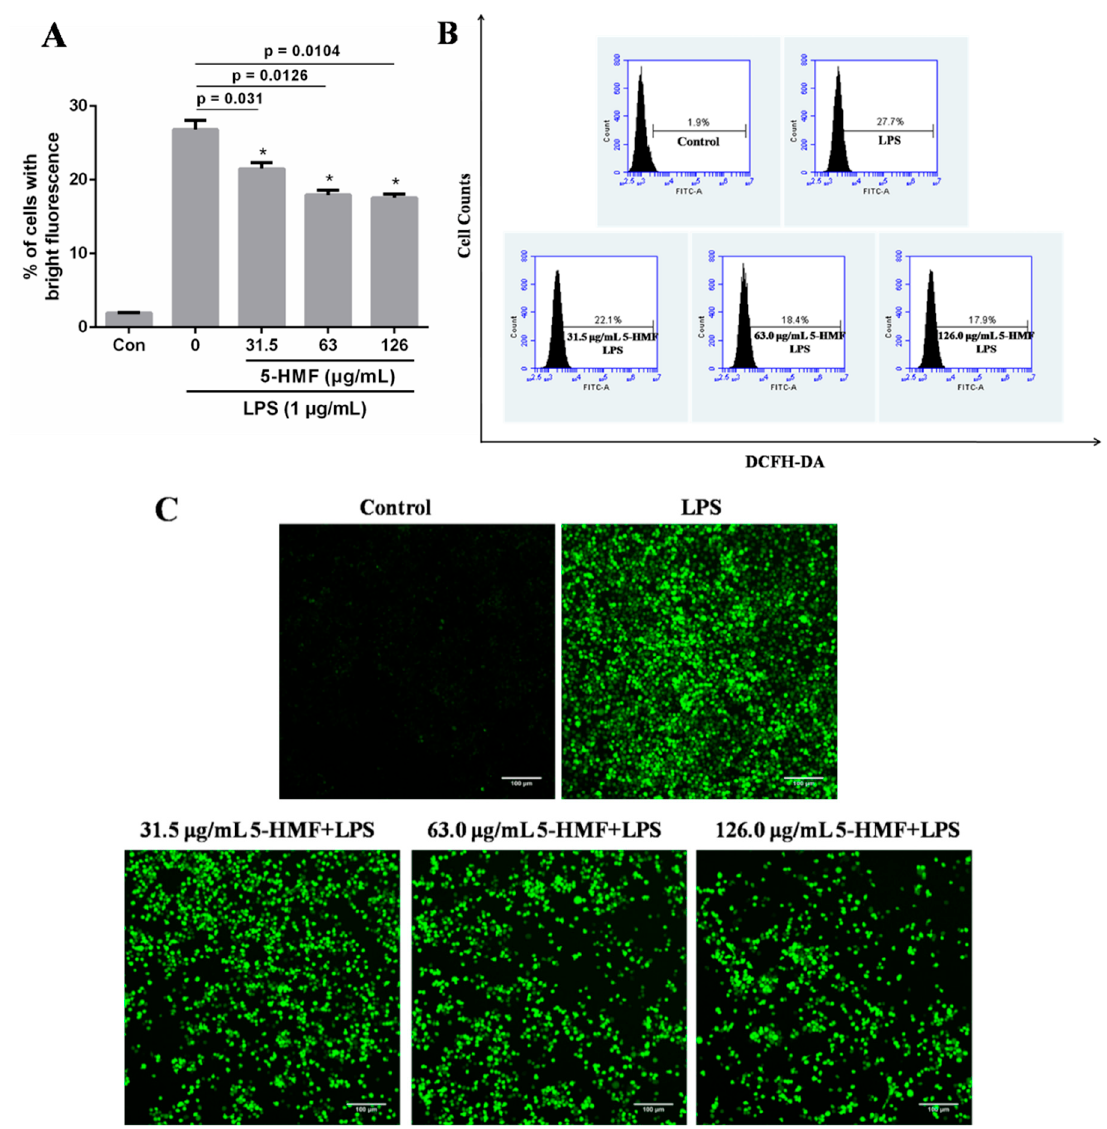
Figure 5. The effect of 5-HMF on the ROS content. The quantitative analysis of intracellular ROS formation in LPS-activated RAW 264.7 cells using flow cytometry. ( A ) The ROS content was expressed as the percentage of cells with bright fluorescence. ( B ) The flow cytometry chart was analyzed by the software (BD Accuri C6 Plus). ( C ) Confocal microscopy images of cells with intracellular ROS. The green fluorescence represents ROS. 5-HMF inhibited LPS-stimulated ROS production in RAW 264.7 cells. RAW 264.7 macrophage cells were pretreated for 6 h with different concentrations of 5-HMF prior to the stimulation of LPS (1 μ g/mL) for 18 h. Data were expressed as means ± SDs (n = 3). *: P < 0.05, compared with the only LPS-induced control group. Scale bar = 100 μ m.